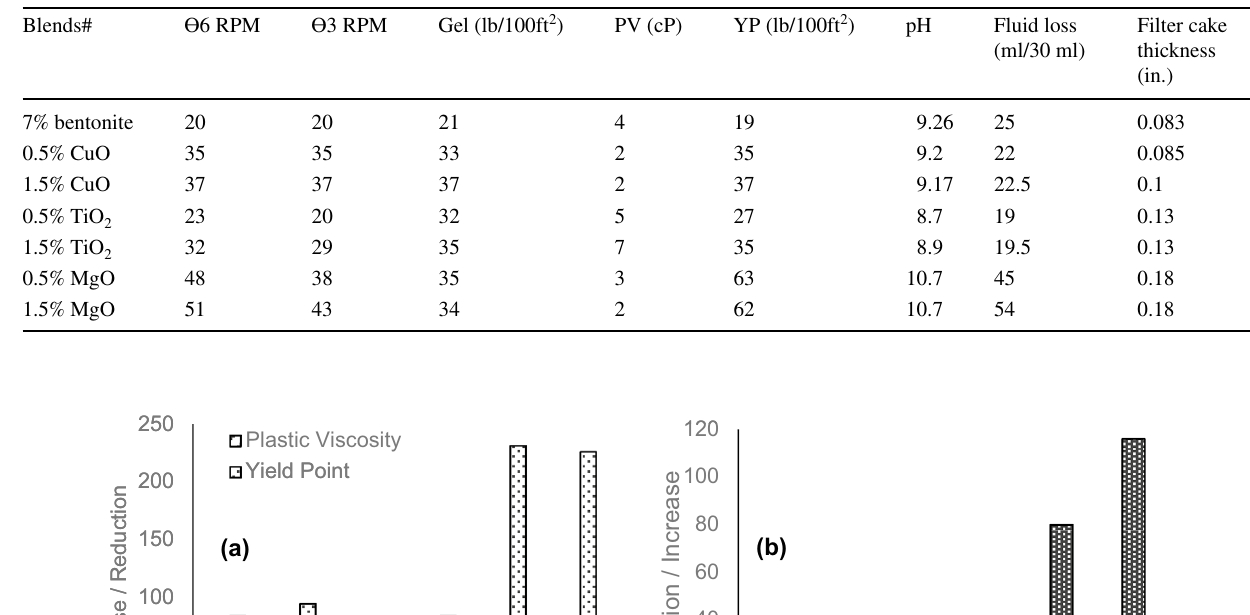
Table 7 Summary of the test results